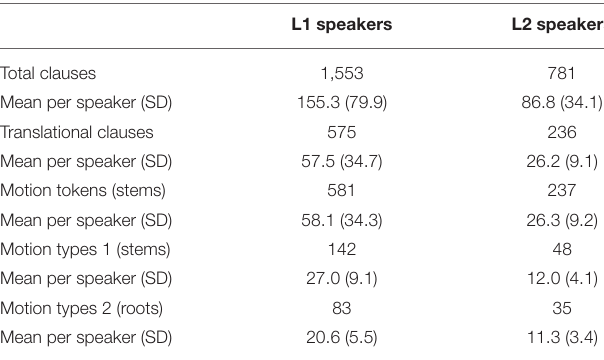
TABLE 2 | Number of clauses, and motion tokens and types in Mapudungun